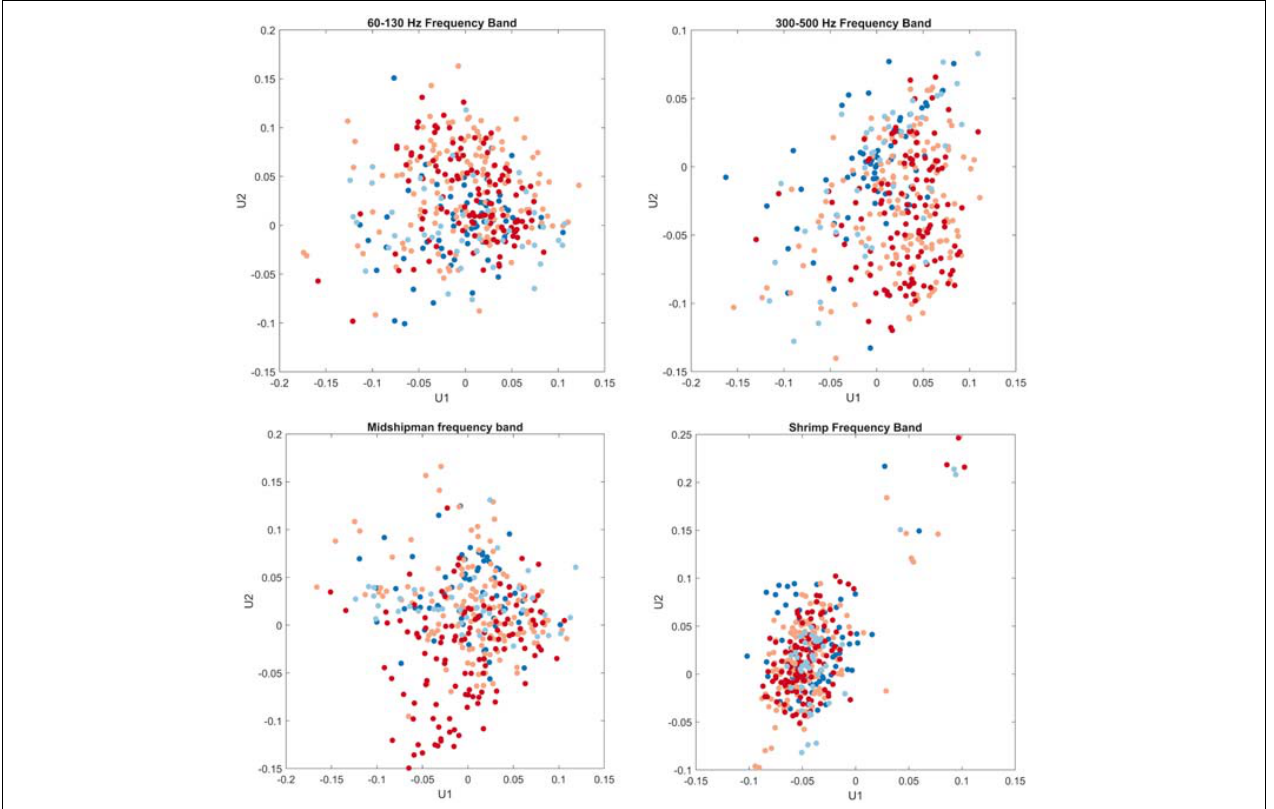
FIGURE 5 | Ordination plot of the four frequency bands of interest based on singular value decomposition. X -axes are the first singular column of the left singular matrix, and y -axes are the second column of the left singular matrix. Colors denote seasons (fall: light blue, winter: dark blue, spring: light red, summer: dark red).